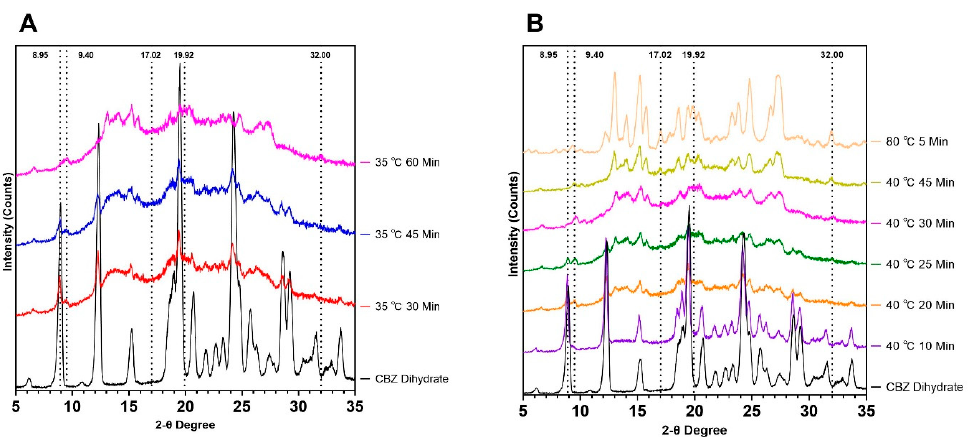
Figure 3. XRPD patterns of dehydrated CBZ dihydrate at 35 °C ( A ) and 40 °C/80 °C ( B ). Three characteristic peaks at 8.95, 17.02/32.00, and 9.40/19.92 two-theta degrees correspond to CBZ dihydrate, form-III CBZ anhydrate, and form-I CBZ anhydrate, respectively. Specifically, at 35 °C, the complete dehydration of CBZ dihydrate was achieved at 60 min, which was confirmed by the absence of 8.95 two-theta peak. The remaining crystals were determined to be a mixture of form-I CBZ anhydrate (9.40 two-theta peak) and form-III CBZ anhydrate (32.00 two-theta peak). For 30 and 45 min, results demonstrate the partial dehydration of CBZ dihydrate into form-I CBZ anhydrate, which was illustrated by the appearance of the peak at 9.40 two-theta degree. Compared to the dehydration kinetics at 35 °C, faster dehydration of CBZ dihydrate was observed at 40 °C, which was illustrated by the disappearance of the CBZ dihydrate two-theta peaks. At 40 °C, CBZ dihydrate was dehydrated into a mixture of form-I CBZ anhydrate (9.40 two-theta peak) and form-III CBZ anhydrate (32.00 two-theta peak) at 30 min. Also, a longer time (45 min) at 40 °C resulted in a crystallinity increase of form-III CBZ anhydrate, which was demonstrated by the increased peak intensities of 17.02/32.00 two- theta peaks. Interestingly, at 35 °C for 60 min or 40 °C for 30 min, most of the dehydrated CBZ dihydrate was obtained as disordered CBZ molecules, which showed the least degree of crystallinity among other samples at higher temperatures. Moreover, at 80 °C, the significant intensity increase of 9.40/19.92 two- theta peaks illustrated that more form-I CBZ anhydrate was obtained following the dehydration of CBZ dihydrate. However, the degree of crystallinity for form-III CBZ anhydrate was slightly reduced, which was confirmed by the decreased intensities of 17.02/32.00 two-theta peaks. In addition, at 44 °C, 50 °C, and 60 °C (Supporting Information Figure S3), CBZ dihydrate was fully dehydrated in as fast as 10 min for 60 °C, and higher temperatures led to a higher degree of crystallinity, which was proven to be form- III CBZ anhydrate (17.02/32.00 two-theta peaks). Meanwhile, the crystallinity of form-I CBZ anhydrate remained unchanged due to the comparable peak intensities of 9.40/19.92 two-theta peaks. Results demonstrate that at a lower temperature (30 °C or 40 °C), the dehydration of CBZ dihydrate resulted in a disordered state of CBZ molecules, which subsequently recrystallized into a mixture of form-III CBZ anhydrate and form-I CBZ anhydrate with a longer time or at a higher temperature. The least degree of crystallinity was achieved at 35 °C for 60 min or 40 °C for 30 min. Additionally, hot stage PLM was conducted to visually study the dehydration process of CBZ dihydrate, as shown in Supporting Information Figure S4. The disappearance of birefringence light from CBZ dihydrate crystals occurred at 80 °C when the sample was heated at a ramp rate of 10 °C/min. The results corresponded to the DSC thermograms of CBZ dihydrate (Figure 1)